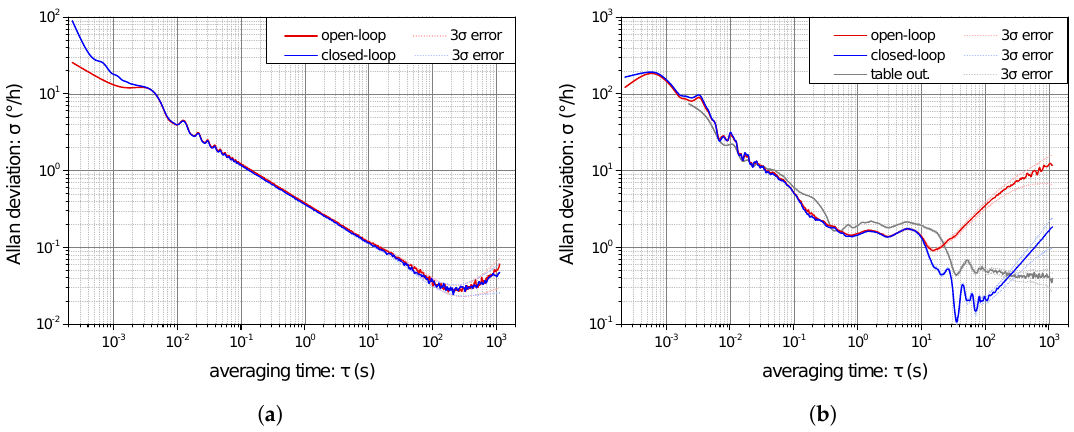
Figure 13. The measured Allan deviation for closed-loop and open-loop I-FOG operation at the zero table angular rate ( a ) and the angular rate of 10 ◦ /s with the direct table velocity output ( b ); the 3 σ error boundaries are marked with the dotted